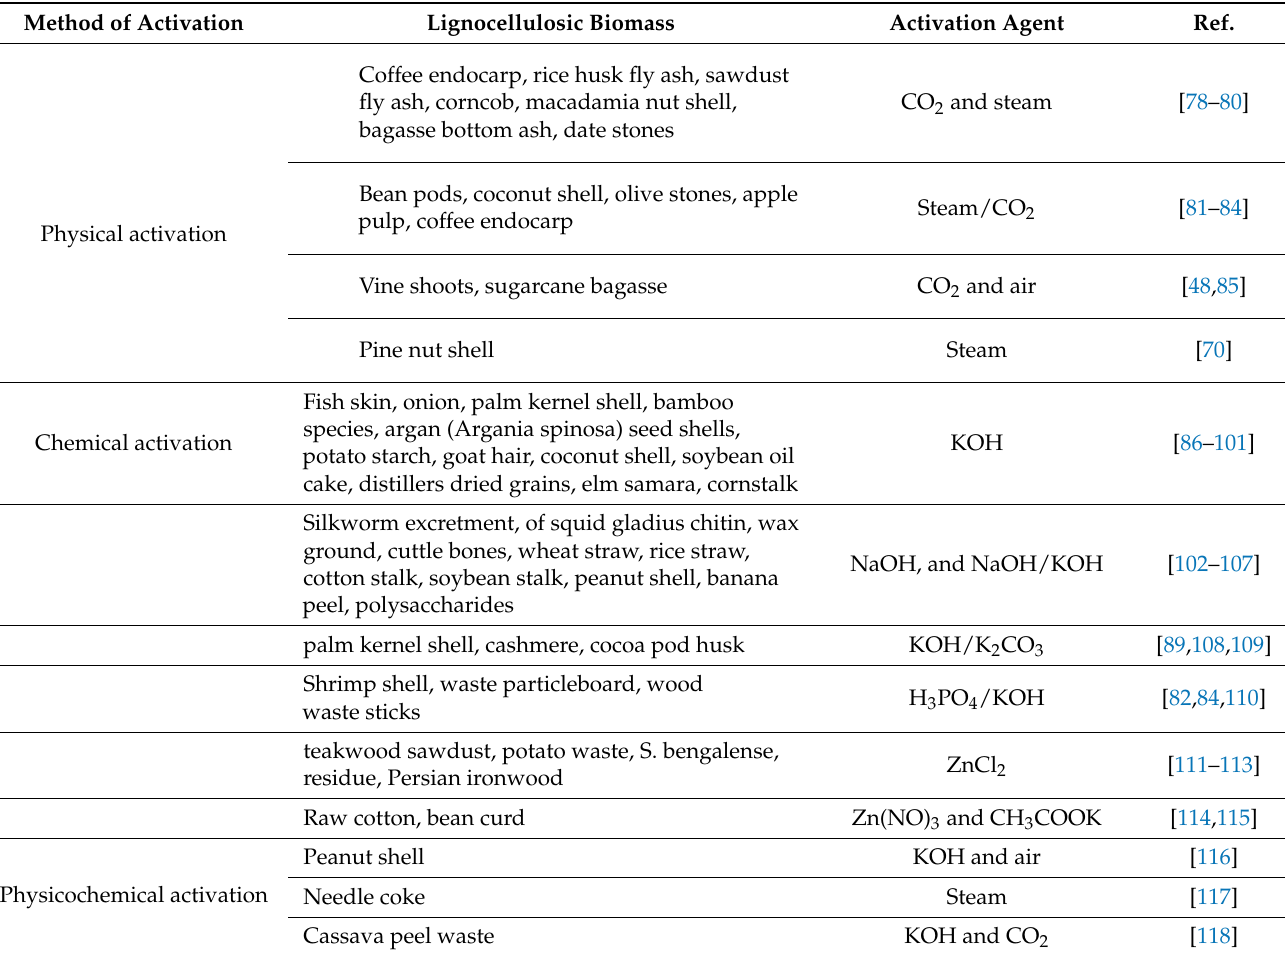
Table 1. Activation methods, chemical activation, physical activation, and physicochemical activation to produce activated carbon from different biomass feedstocks using different activation agents. Adapted with permission from Ref.